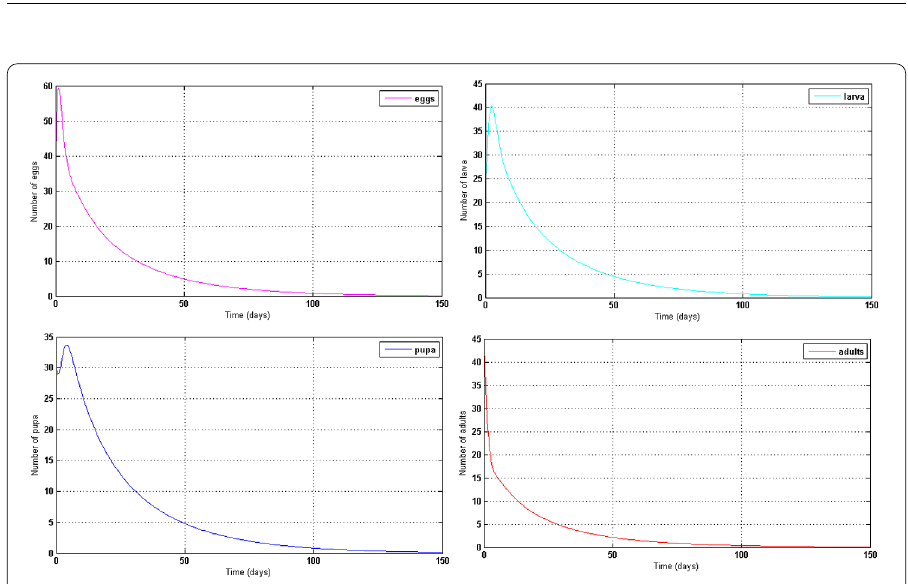
Figure 3 Evolution of eggs, larvae, pupae and adults for b = 2, S E = 0.6, d E = 0.3, s L = 0.4, d L = 0.3, s P = 0.25, d P = 0.15 and f m = 0.6. We get r = 0.7937, which is less than